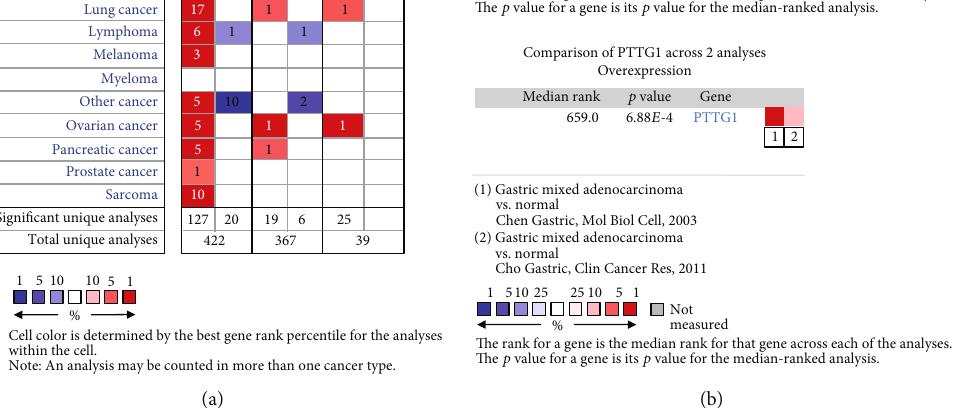
Figure 1: (a) The mRNA expression levels of PTTGs in 20 distinct cancer illnesses (Oncomine). The graph displays the number of datasets with elevated (red) and downregulated (blue) changes in the target gene ’ s mRNA expression that is statistically signi fi cant. Student ’ s t -test was used to compare variations in mRNA levels. The following settings were chosen: p < 0 : 05 , foldchange = 1 : 5 , gene rank = 10 % , and data type = mRNA . The false discovery rate (FDR) approach was used to perform the multiple testing adjustment. (b) PTTG1 mRNA expression in GC was meta-analyzed using data from various Oncomine